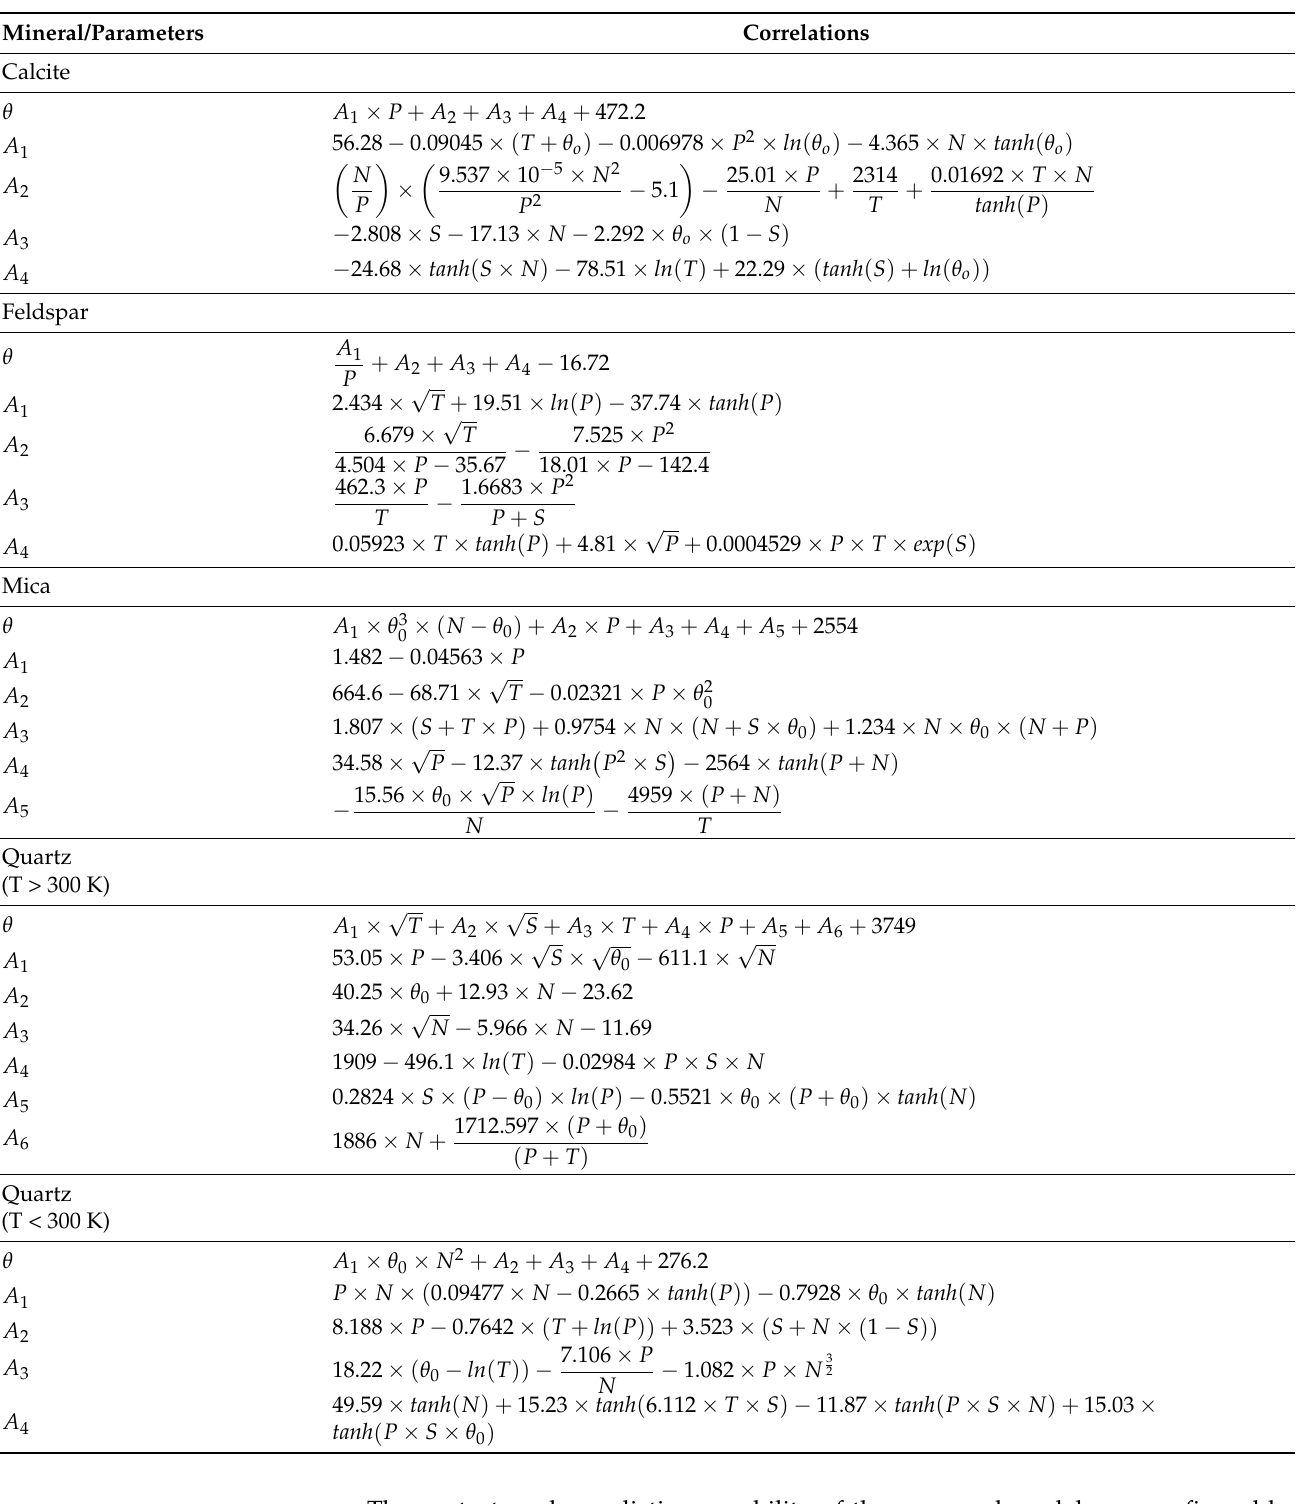
Table 3. Final explicit correlations for estimating the brine/CO 2 /mineral